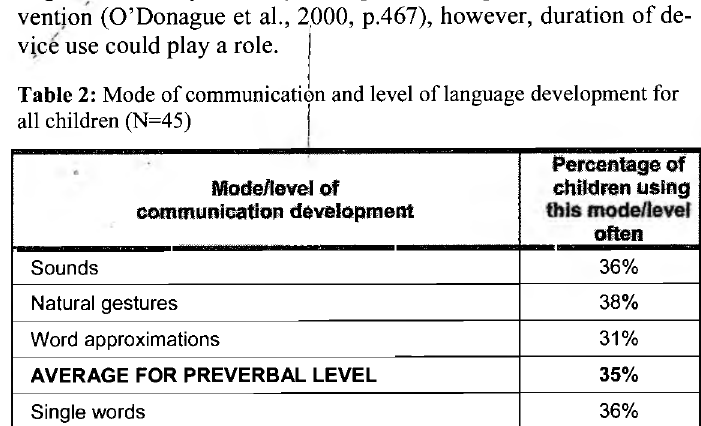
Table 2: Mode of communication and level of language development for all children